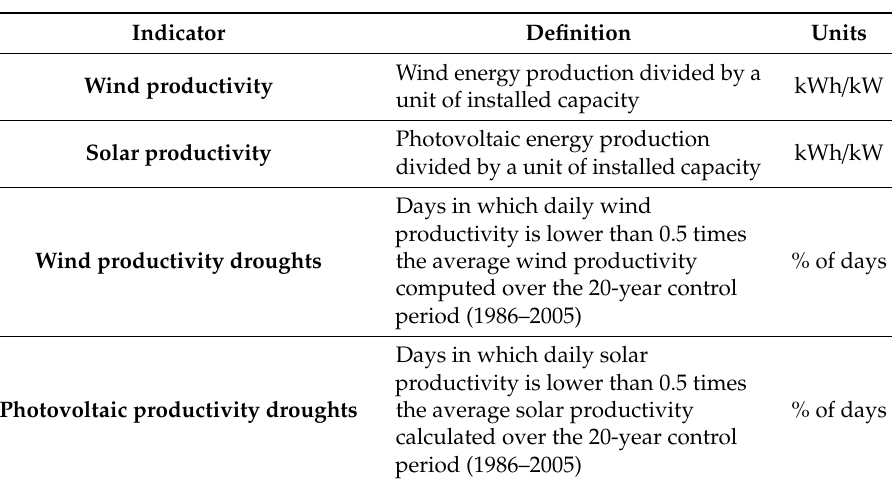
Table 2. Definition and units of the indicators presented in the